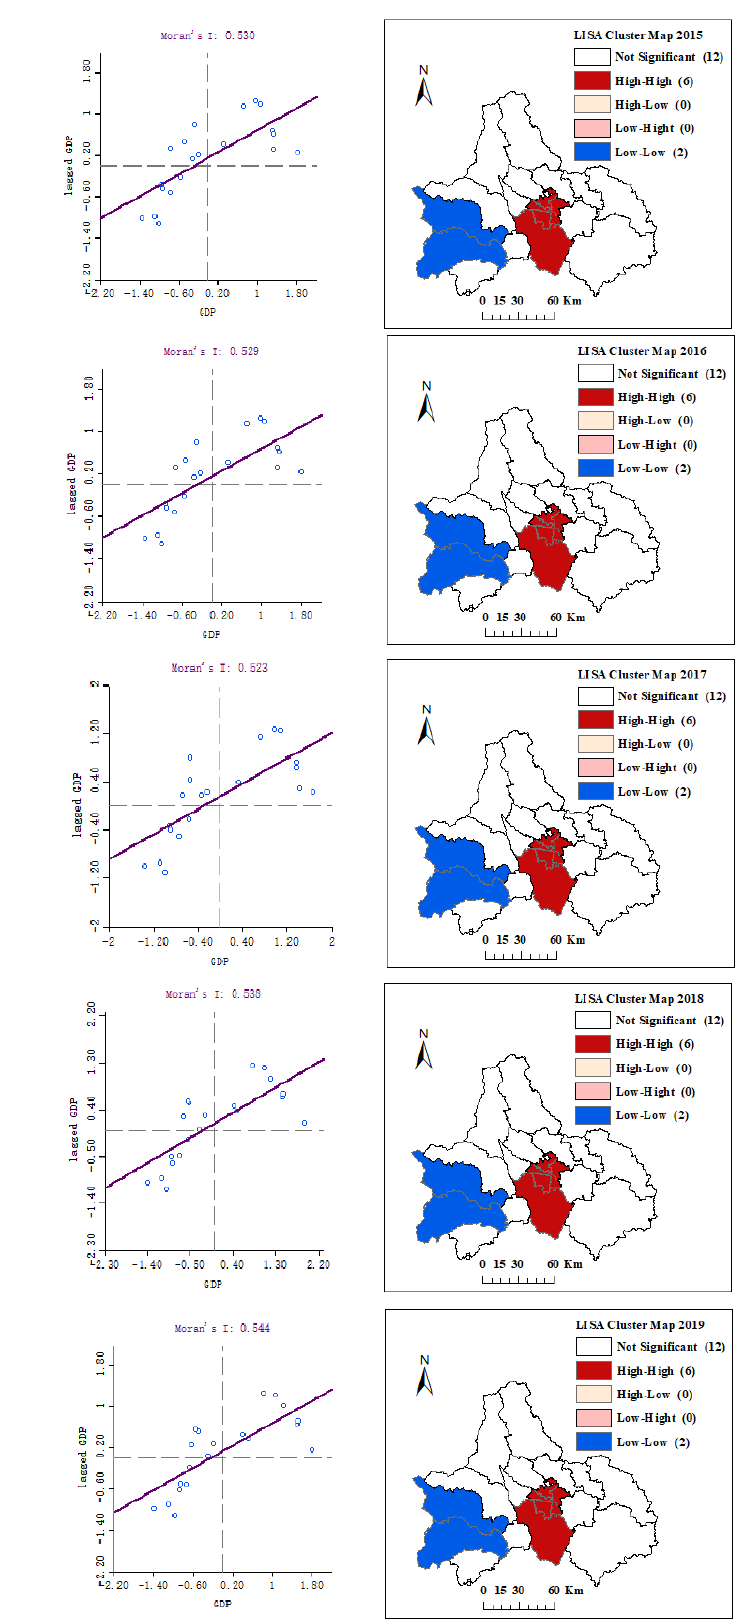
Figure 9. Local Moran’s scatter plot and LISA cluster